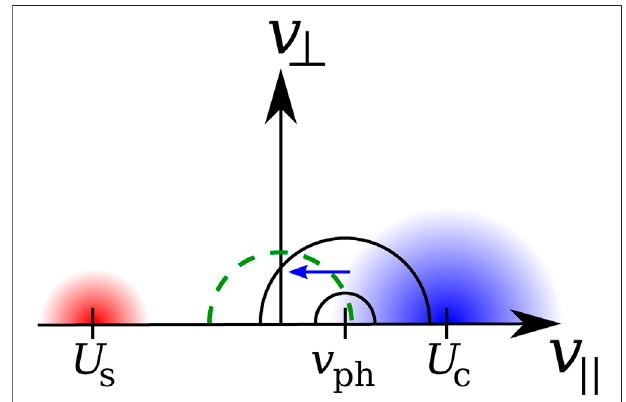
FIGURE 6 | Schematic illustration of the quasi-linear diffusion in the electron/ion-acoustic instability and in the kinetic Alfvén heat- fl ux instability. The blue shaded area represents the core electron population with bulk velocity U c , and the red shaded area represents the strahl population with bulk velocity U s . The black semi-circles represent Eq. 17 for either wave type with parallel phase speed v ph . The diffusive fl ux of Landau-resonant particles is shown by the blue arrow. The green-dashed semi-circle indicates v 2 ⊥ + v 2 (cid:2) (cid:3) constant. In our geometrical convention with v ph > 0, U s < 0 here, which indicates that the diffusive fl ux points in the − B 0 direction. We note that U s < 0 still corresponds to the anti-sunward direction if B 0 points towards the